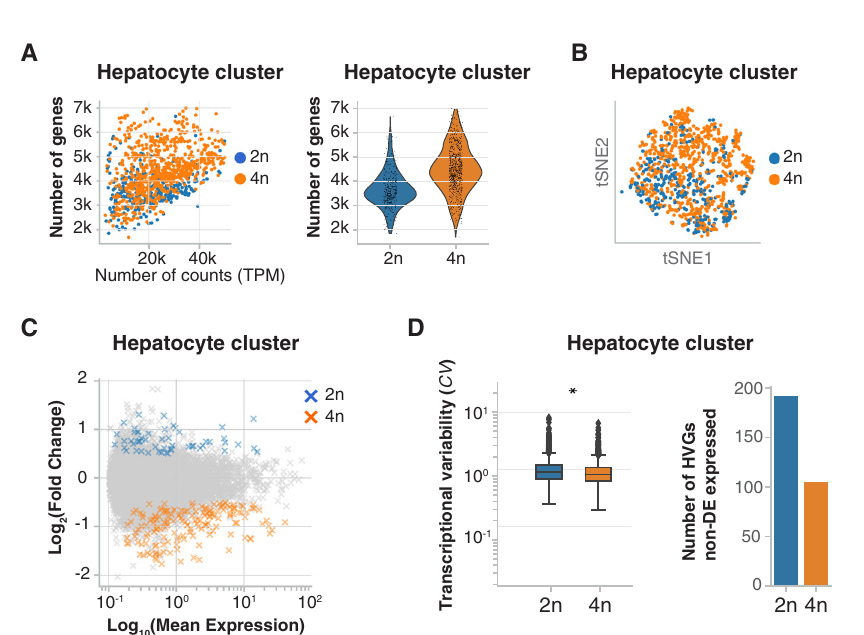
Fig. 3 snRNA-seq2 reveals differences in gene expression between diploid and tetraploid hepatocytes. A Scatterplot showing the higher number of genes per gene-length normalized counts (TPM) detected in 4n hepatocytes compared with 2n hepatocytes (left). The violin plot showing that the number of genes in 4n nuclei is 1.25-times higher than in 2n hepatocytes (right). B tSNE embedding of the hepatocyte cluster showing that 2n and 4n nuclei are clustered together. C MA plot showing average logarithmically transformed mean expression ( x -axis) versus the log 2 fold change ( y -axis) for pairwise comparison between 2n and 4n hepatocytes; 312 differentially expressed genes (DEGs) are depicted with crosses: 64 genes are upregulated in 2n nuclei (blue) and 248 genes are upregulated in 4n (orange). D Box plot of the coef fi cient of variation showing the transcriptional variability between 2n ( n = 320) and 4n ( n = 741) (left; two-sided Mann − Whitney U-test, *: p -value = 2.09e − 14.). Box plots show the median coef fi cient of variation per ploidy status. The lower and upper ends of the boxes correspond to fi rst and third quartiles, respectively, while the whiskers extend to minimum ( fi rst quartile minus 1.5 × the inter-quartile range (IQR)), and maximum (third quartile plus 1.5 × IQR). Data points beyond the whiskers are shown as individual points. Bar plot showing the higher number of highly variable genes (HVGs) that are not differentially expressed (non-DE) in 2n vs 4n